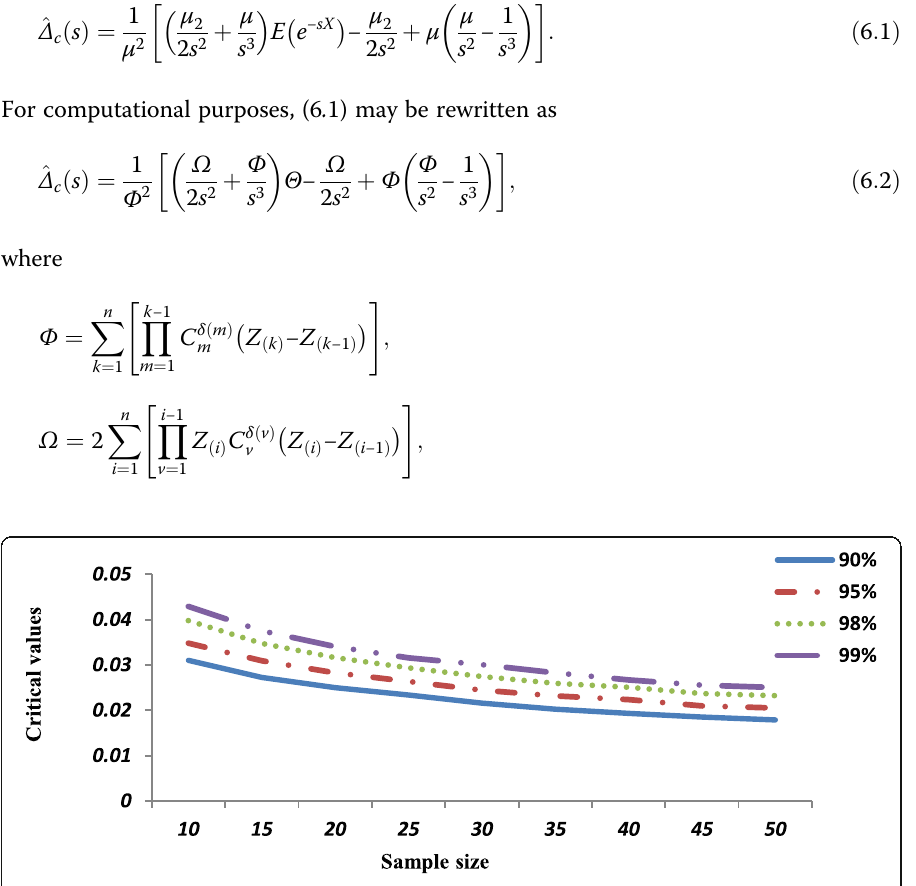
Fig 1 Relation between critical values, sample size and confidence